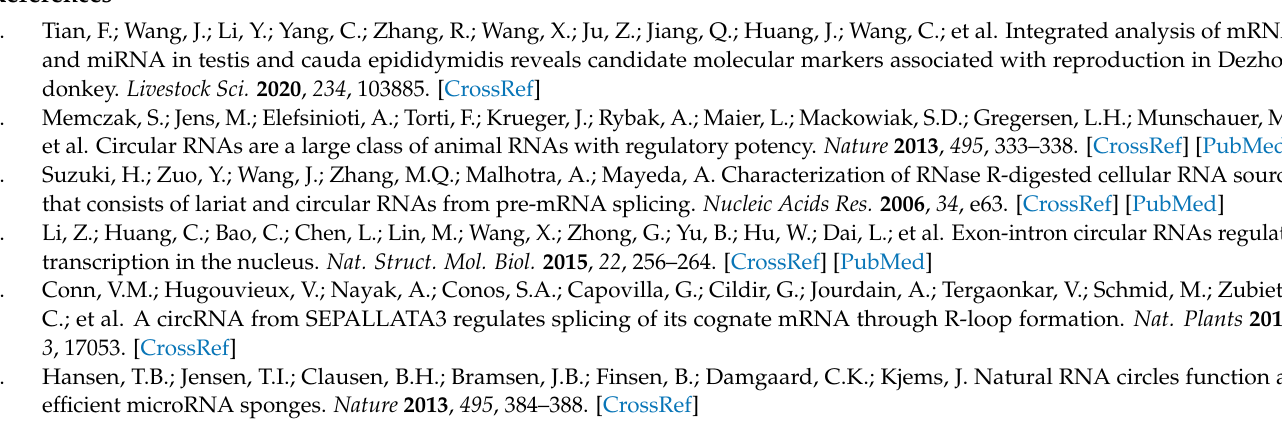
Table S1: The general information of clean data from transcriptome sequencing.; Table S2: all information of identified circRNAs and their host genes.; Table S3: The expression of circRNAs identified from testis and caput epididymis.; Table S4: The KEGG pathways for the the co-expressed and specifically expressed host genes in testis and caput epididymis.; Table S5: The data quality of small RNA sequencing.; Table S6: The expression of identified microRNAs in testis and caput epididymids.; Table S7: The information of differentially expressed microRNAs between testis and caput epididymidis.; Table S8: The predicted target genes of microRNAs.; Table S9: The differentially expressed information of circRNAs.; Table S10: The GO annotation terms and KEGG pathway analysis for the up_regulated expressed circRNA’ host genes.; Table S11: The KEGG pathway analysis and GO annotation for the down_regulated expressed circRNA’ host genes.; Table S12: The predicted target microRNAs of differentially expressed circRNAs in donkey testis and caput epididymis.; Table S13: Primers of six validated testis derived circRNAs for general and quantitive